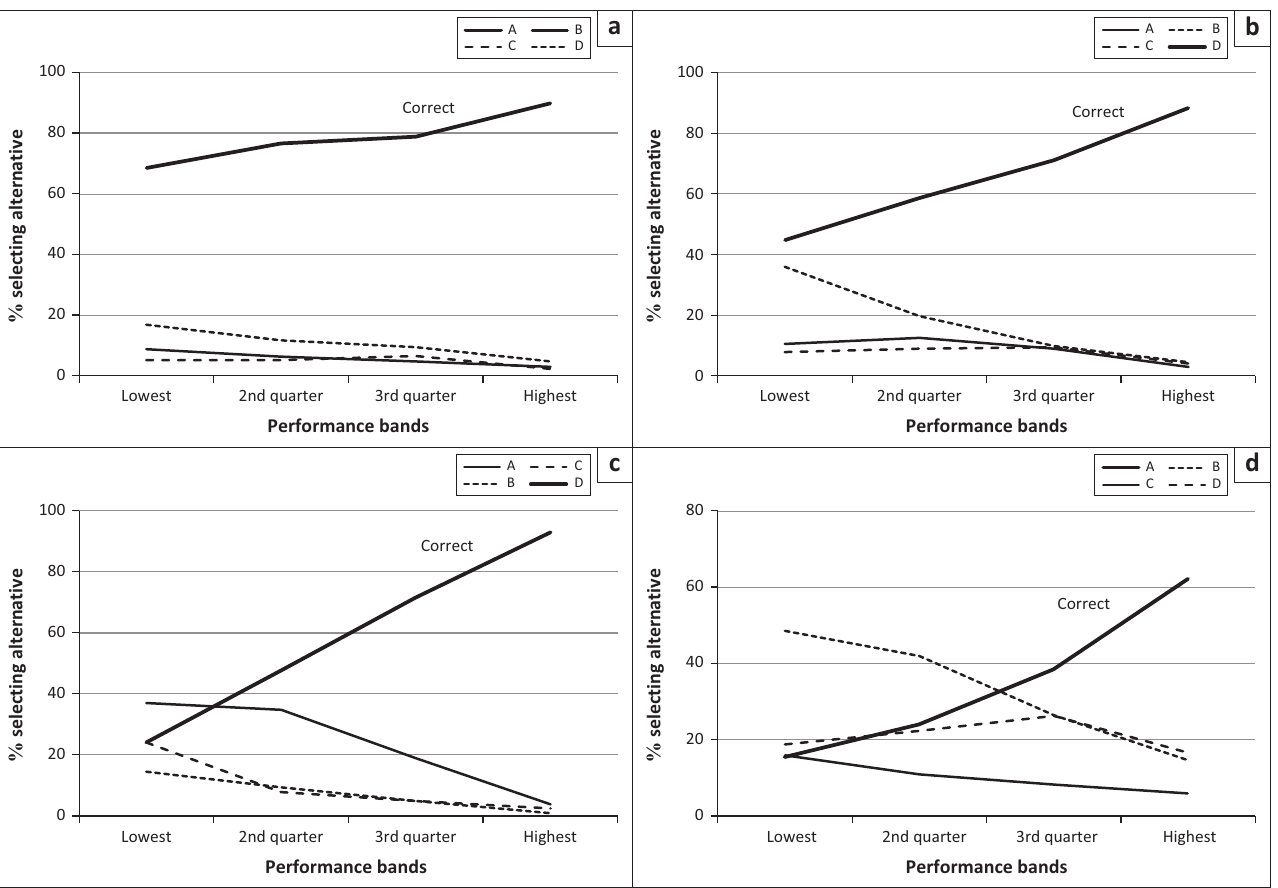
FIGURE 1: Results for missing value, by performance band.